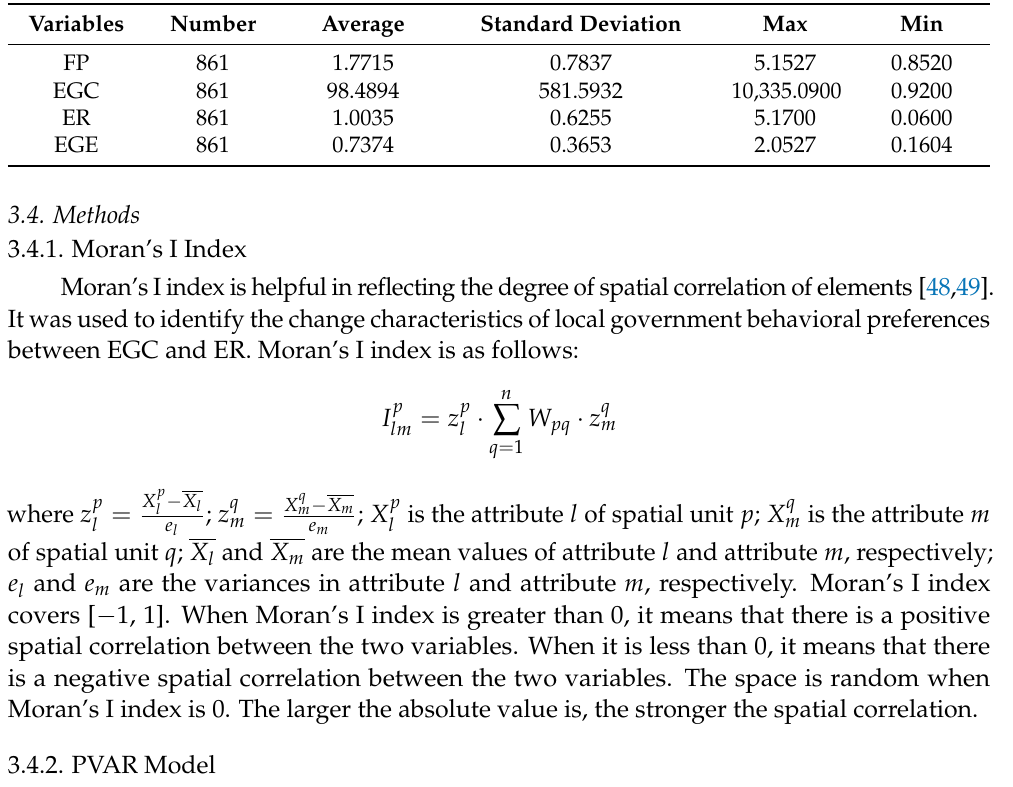
Table 2. Descriptive statistics of the